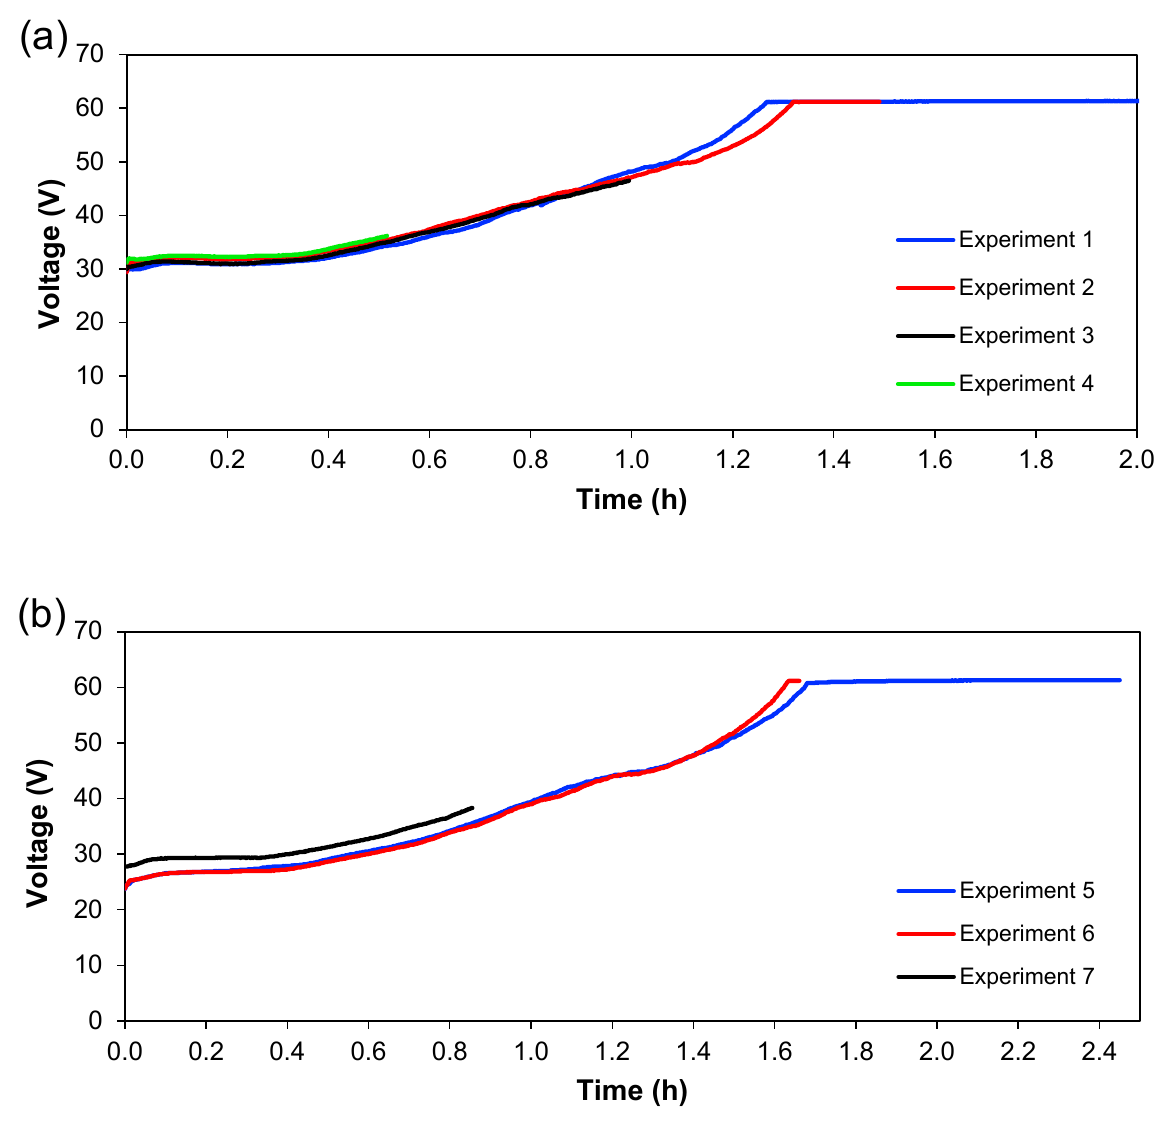
Figure 7. The voltage drop over the cell with time. ( a ) Series 1, ( b ) Series 2.